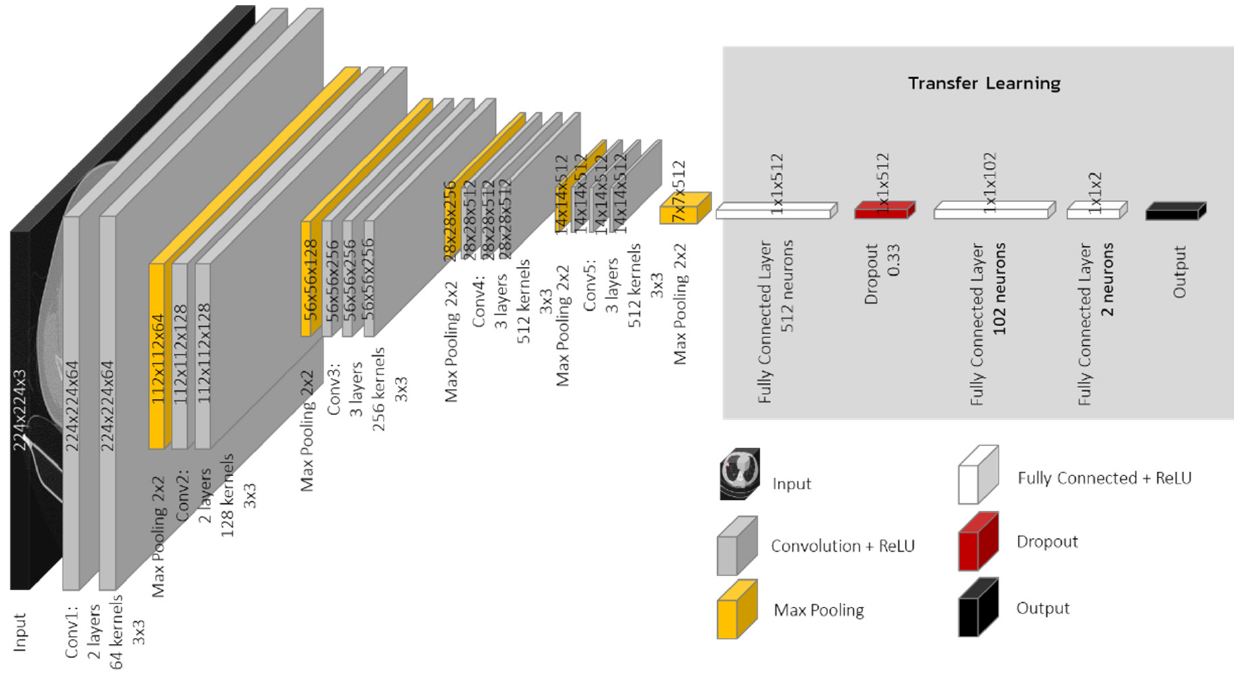
Figure 2. VGG-16 Architecture of this research.